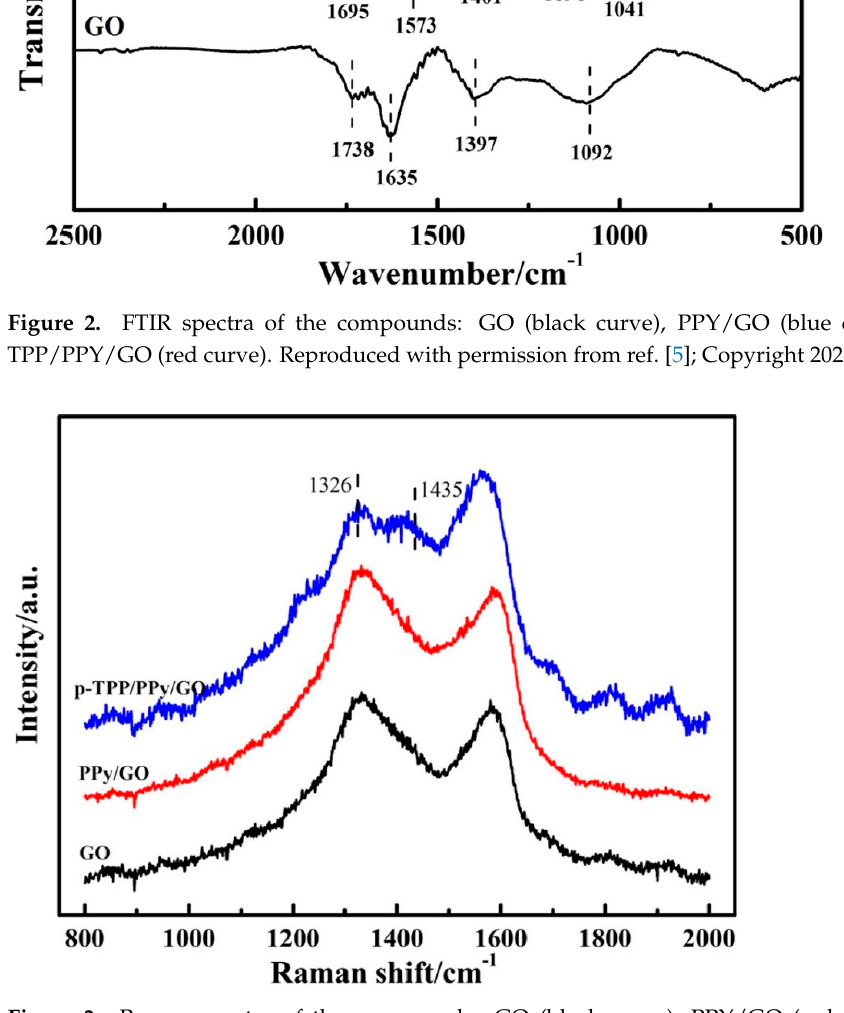
Figure 2. FTIR spectra of the compounds: GO (black curve), PPY/GO (blue curve), and p- TPP/PPY/GO (red curve). Reproduced with permission from ref. [5]; Copyright 2022 Springer.